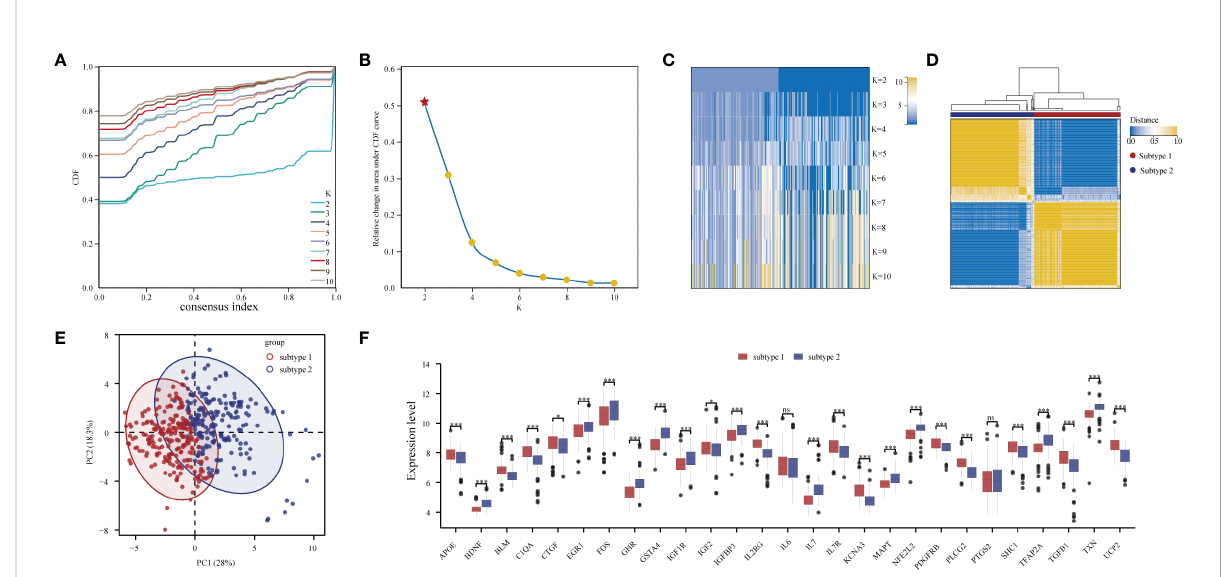
FIGURE 7 Unsupervised clustering of 27 DE-ARGs. Identifying two distinct ARG-subtypes in PD. (A) Consensus clustering cumulative distribution function (CDF) for k = 2- 10. (B) Relative change in area under CDF curve for k = 2- 10. (C) Heatmap of k with two subtypes in periodontitis. (D) Heatmap exhibiting the two subtypes of PD samples with k =2. (E) Principal component analysis for the transcriptome pro fi les of the two distinct subtypes, showing a remarkable difference in transcriptome between different subtypes. (F) The expression status of 27 DE-ARGs in the two subtypes (*p < 0.05, ***p < 0.001, and ns means not signi fi